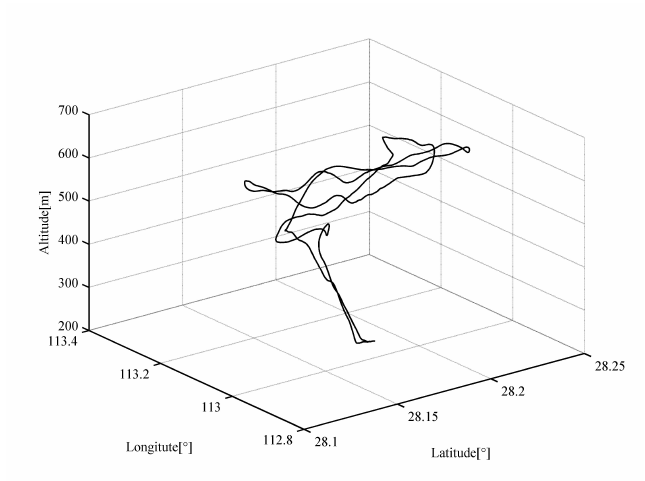
Figure 2. Actual flight trajectory.